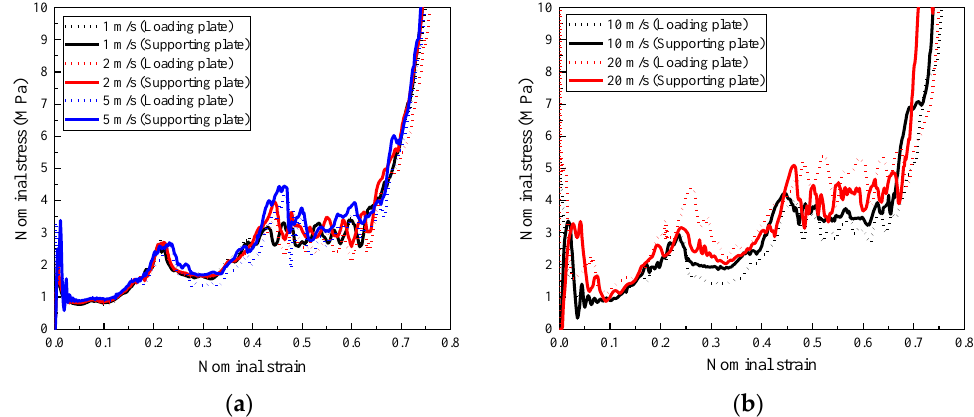
Figure 25. The stress–strain relationships of the composite calculated from the contact forces between the composite and loading plate and supporting plate ( t = 0.4:0.4:0.4 and ρ = 848:575:408): ( a ) 1 m/s, 2 m/s, and 5 m/s; ( b ) 10 m/s and 20 m/s.